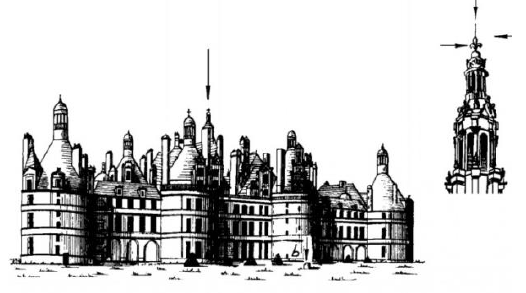
Figure 3: Permanent ground control points (red triangles)